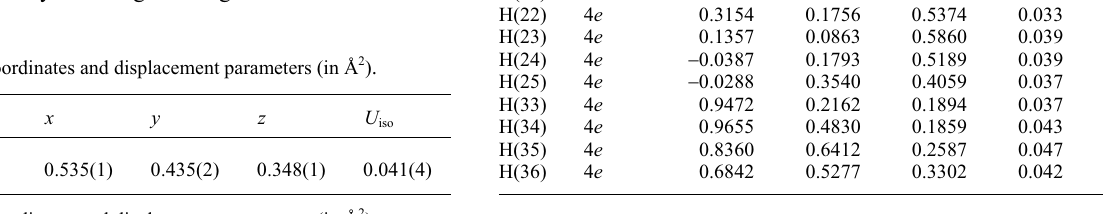
Table 3. Atomic coordinates and displacement parameters (in Å 2 )